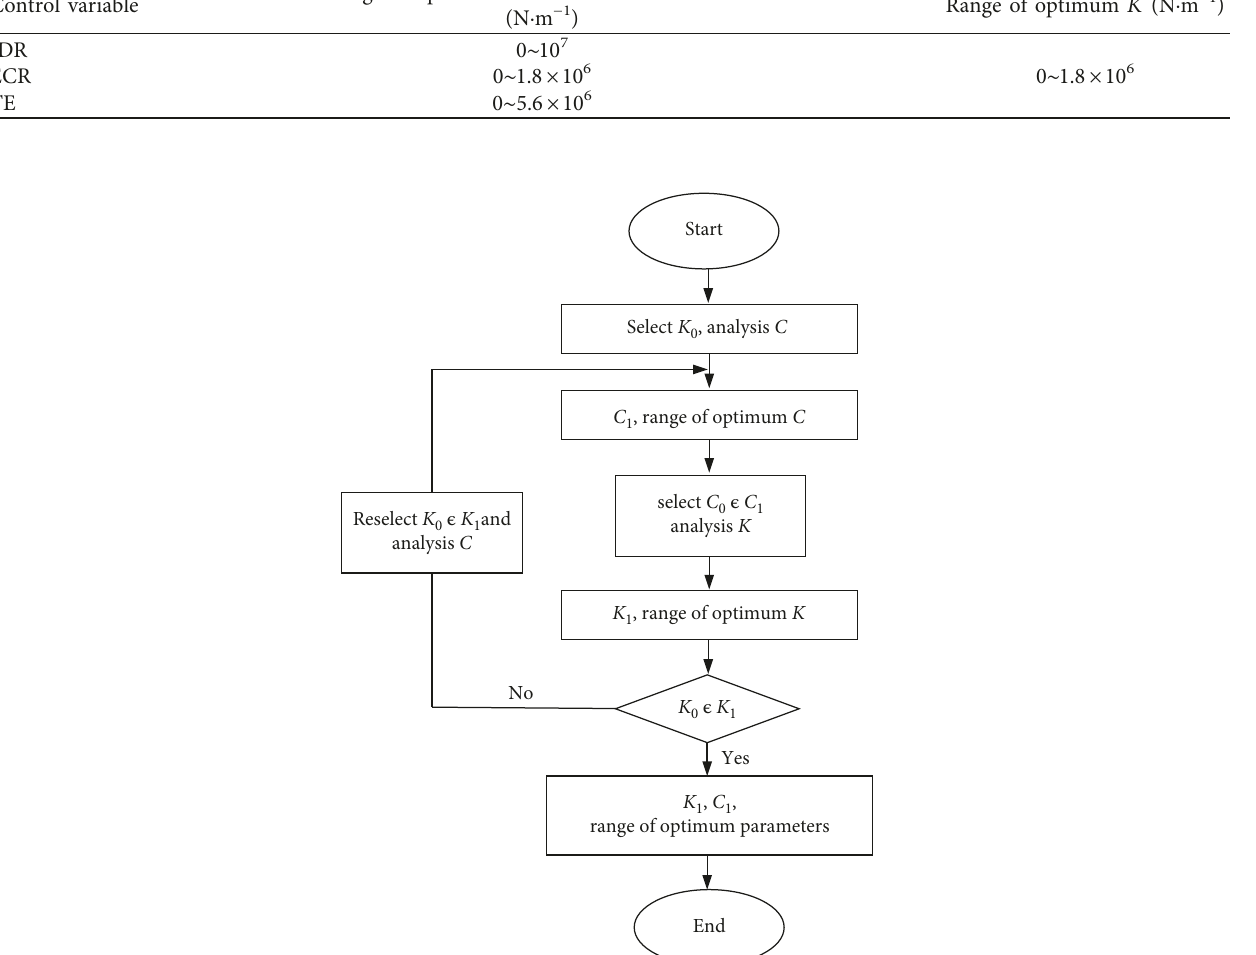
Control variable